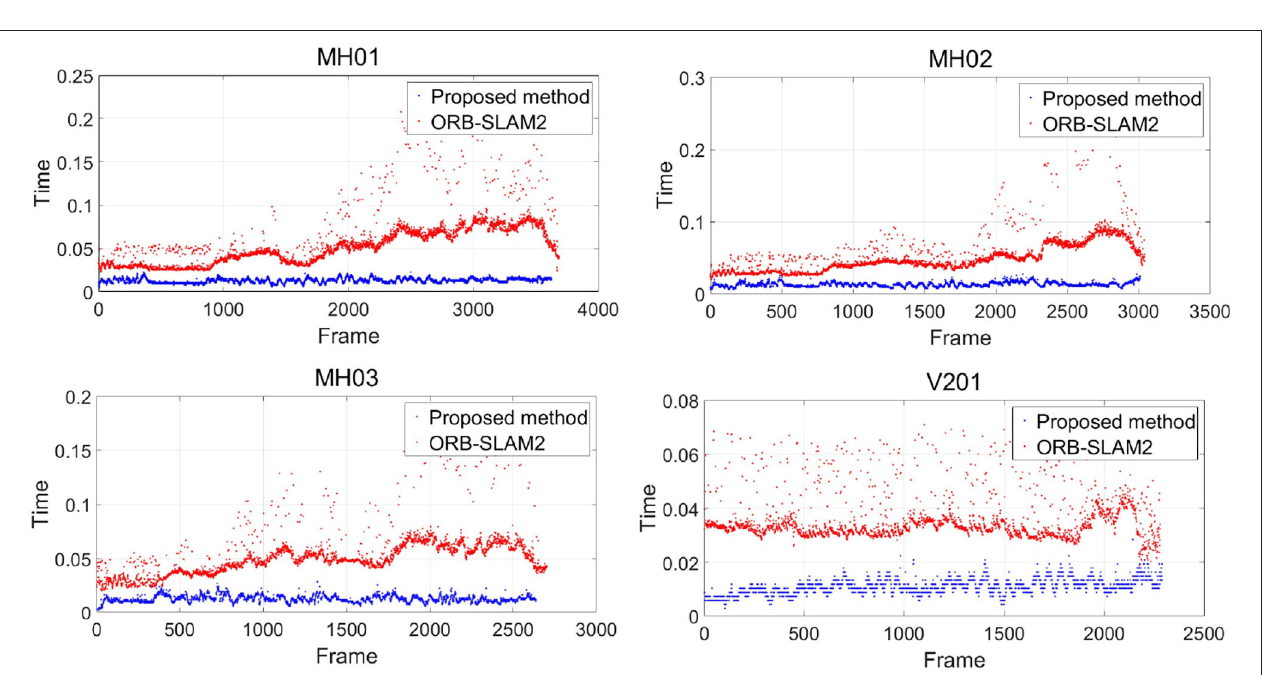
FIGURE 7 | (Left): The position illustration of the target box and the feature points; (Right): The result of the statistical outlier filter.